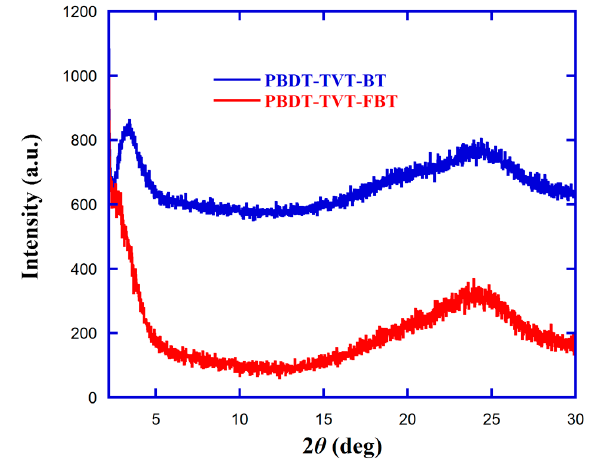
Figure 4. X-ray patterns of PBDT-TVT-BT and PBDT-TVT-FBT film on glass.